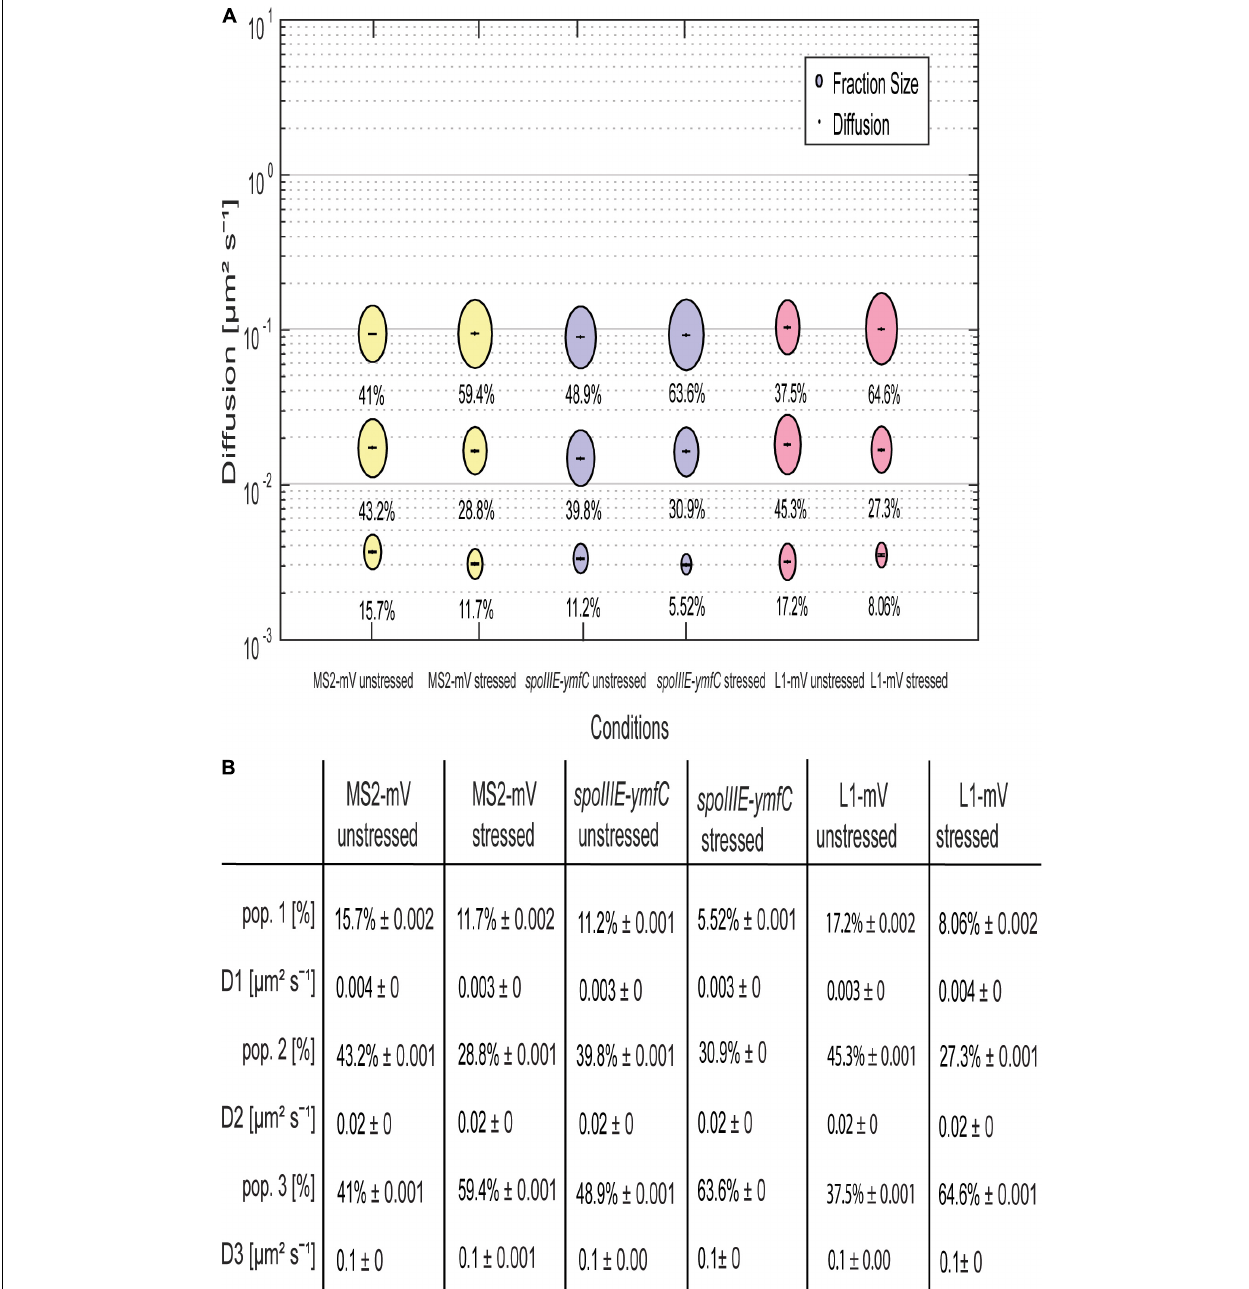
FIGURE 7 | Rifampicin stress affects population sizes of mRNA and of ribosomal protein L1. For the determination of the diffusive coefficient and the fraction size, SQD was used. (A) The bubble plot shows the size of the fraction where each bubble is proportional to the area of its corresponding diffusion coefficients. MS2-mVenus is shown in yellow, whereas the mRNA operon spoIIIE-ymfC is shown in purple. L1-mVenus is colored in pink. In Table (B) —another way to display the SQD results—the data shown are the population sizes in% at a fixed DC that fits best to all three conditions, for better comparison if there are changes. For the stressed conditions, 50 µ g/mL rifampicin was added to the cells for 40